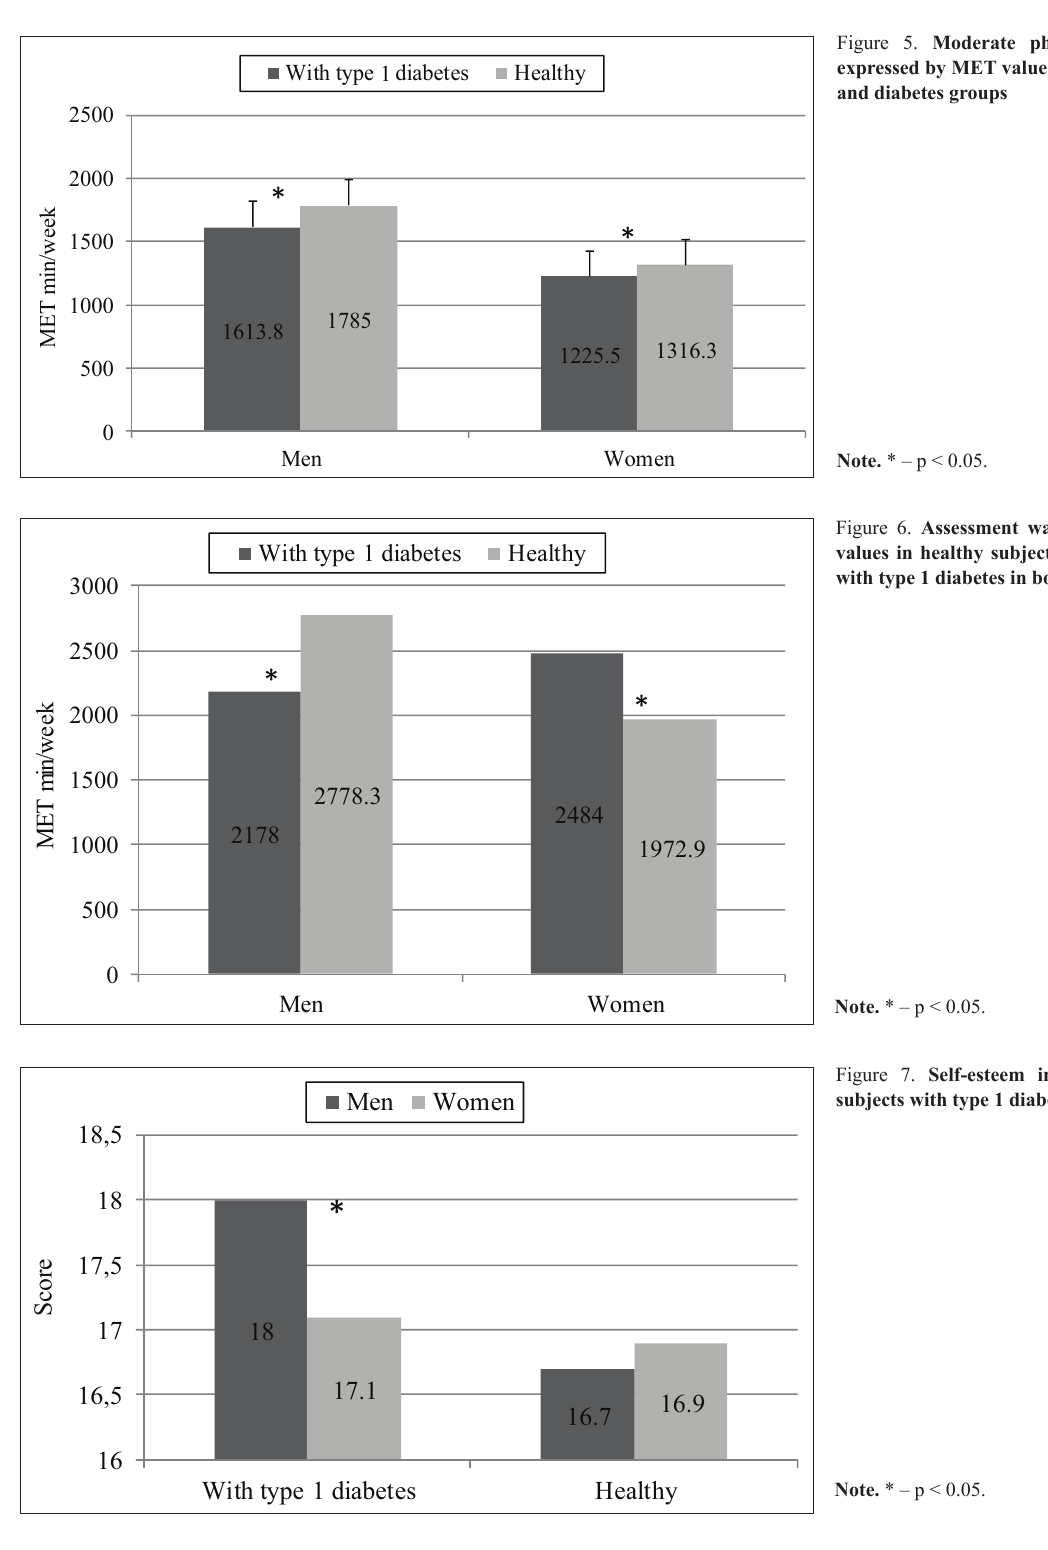
Figure 7. Self-esteem in healthy and subjects with type 1 diabetes groups